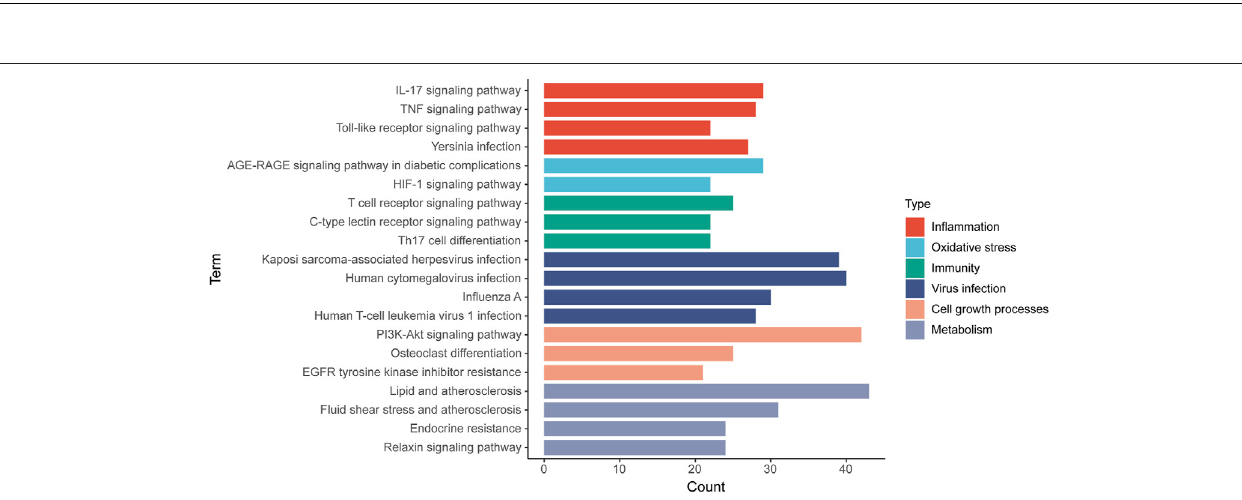
FIGURE 9 | The classi fi cation of KEGG pathways. The results of KEGG pathway enrichment analysis are classi fi ed into fi ve types and a color represents a type. Column represents KEGG pathway terms and row represents the number of targets enriched on the pathways.